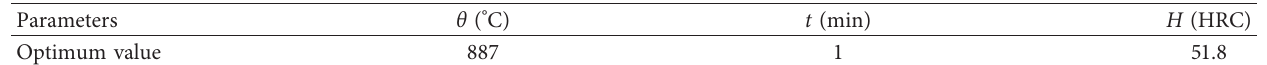
Table 8: Optimum values for quenching